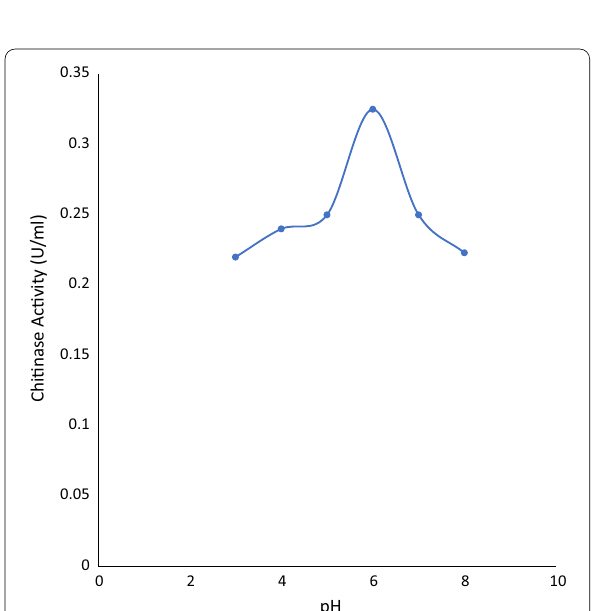
Fig. 2 Chitinase producing activity of Streptomyces albus at different temperature